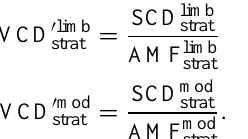
and SCD mod strat